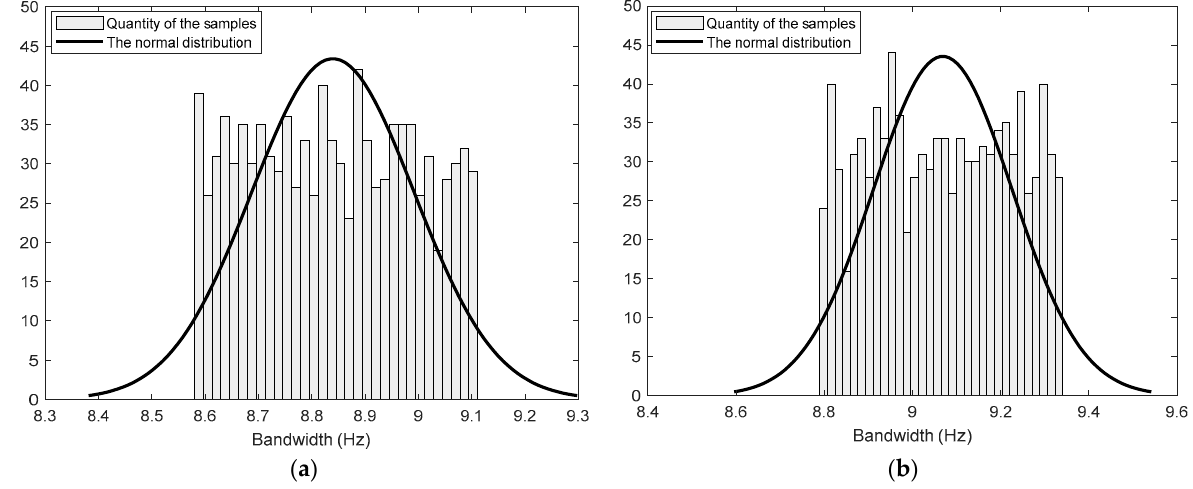
Figure 10. The Monto Carlo analysis results of the bandwidth constraint. ( a ) The design using 8.6 mL/rev displacement pump. ( b ) The design using 9.5 mL/rev displacement pump.